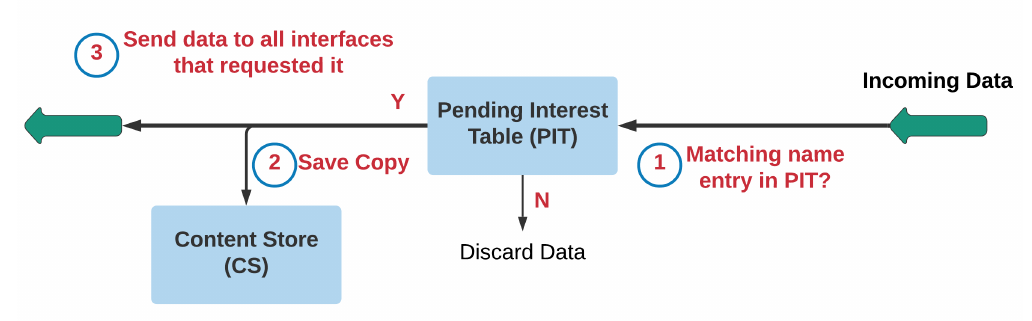
Figure 2. Data packet forwarding